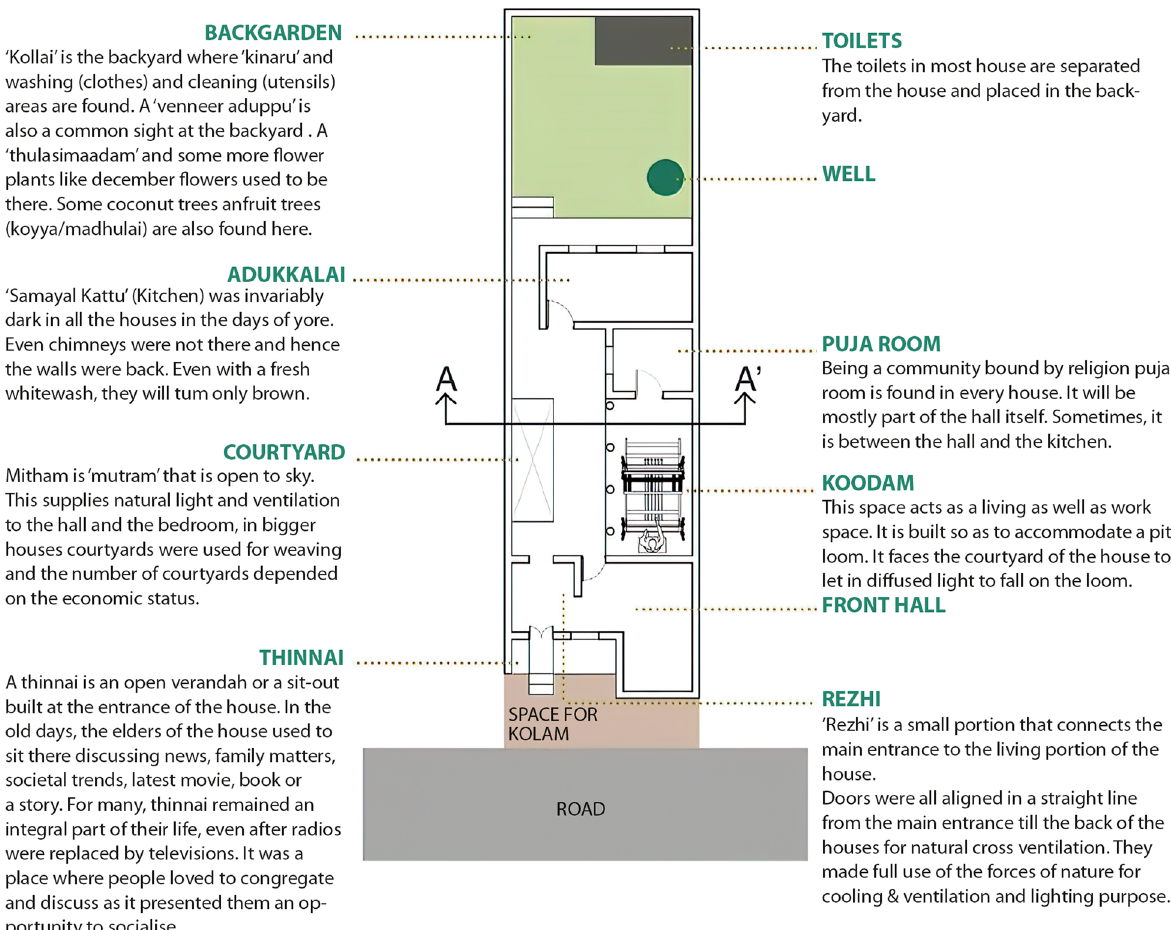
Fig. 13 Floor plan of traditional single-family dwelling and its spatial characteristics (Source: the author)